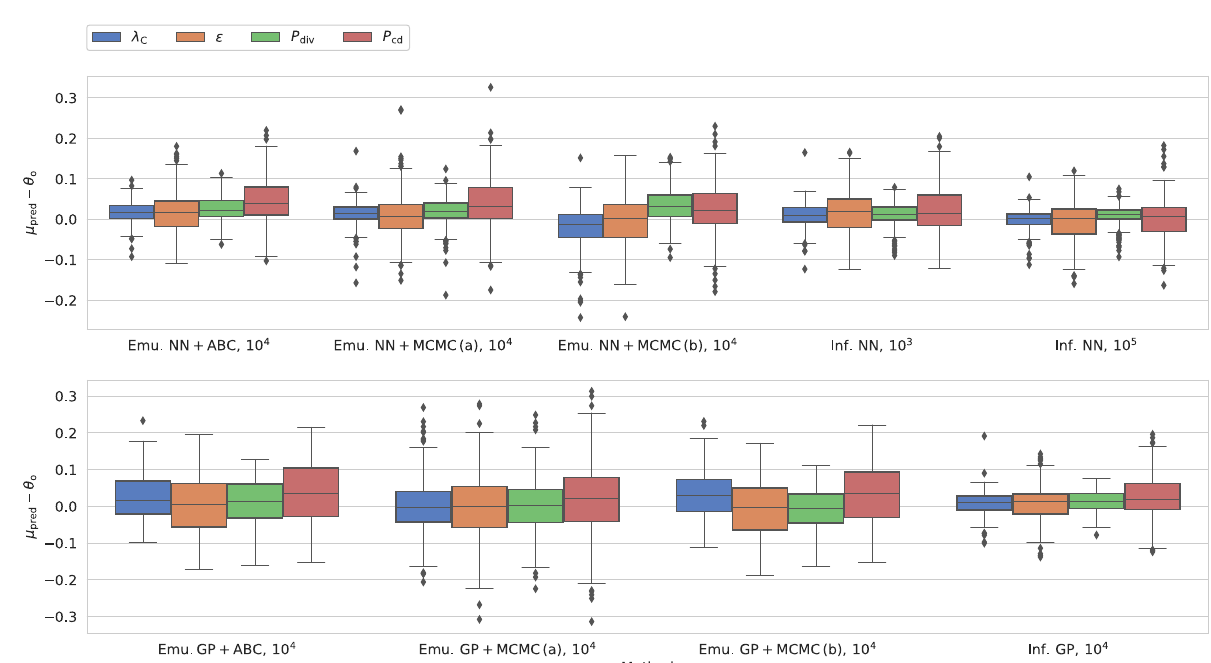
Fig 4. Performance across different inference schemes for our cancer CA model in terms of the residuals between the mean of the marginal distribution and the true parameter values ( θ o ). For other metrics, we refer the reader to S9 Fig. The plot includes the results from the emulation- based approaches (emu.) and our direct inference machines (inf.). We include two machine learning approaches: a neural network (NN) and Gaussian processes (GP). In connection with the emulators, we distinguish between results obtained using rejection ABC and MCMC. For each approach, the label specifies the size of the training set: For the emulators, we consistently used 10 4 simulations.